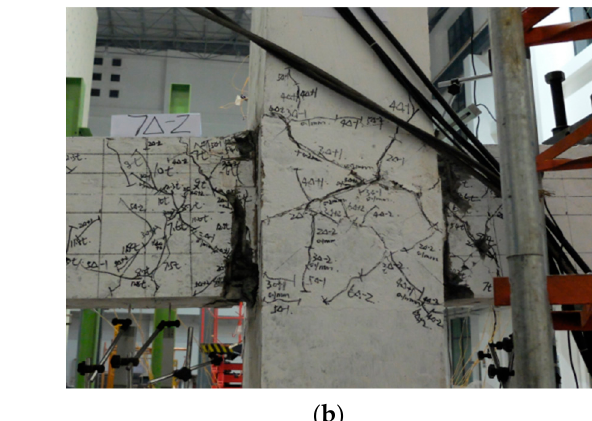
Figure 7. Cyclic displacement-controlled loading history.